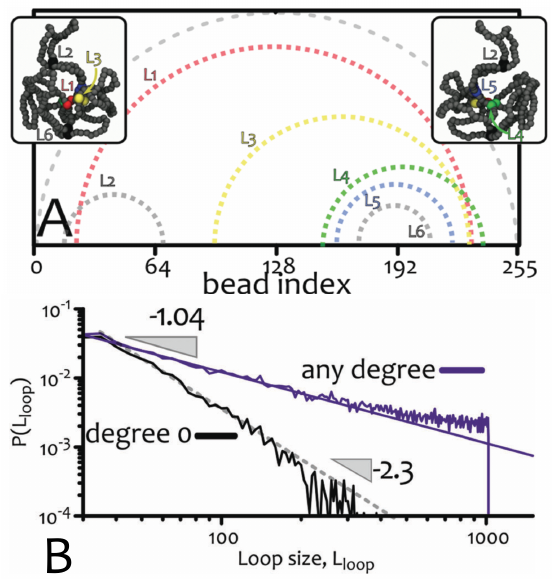
Figure 9. ( A ) Arc-representation of a ring conformation. An arc is drawn between beads forming a contact, i.e., a loop (L1–L6 in the figure). ( B ) Probability distribution of loop size length L loop